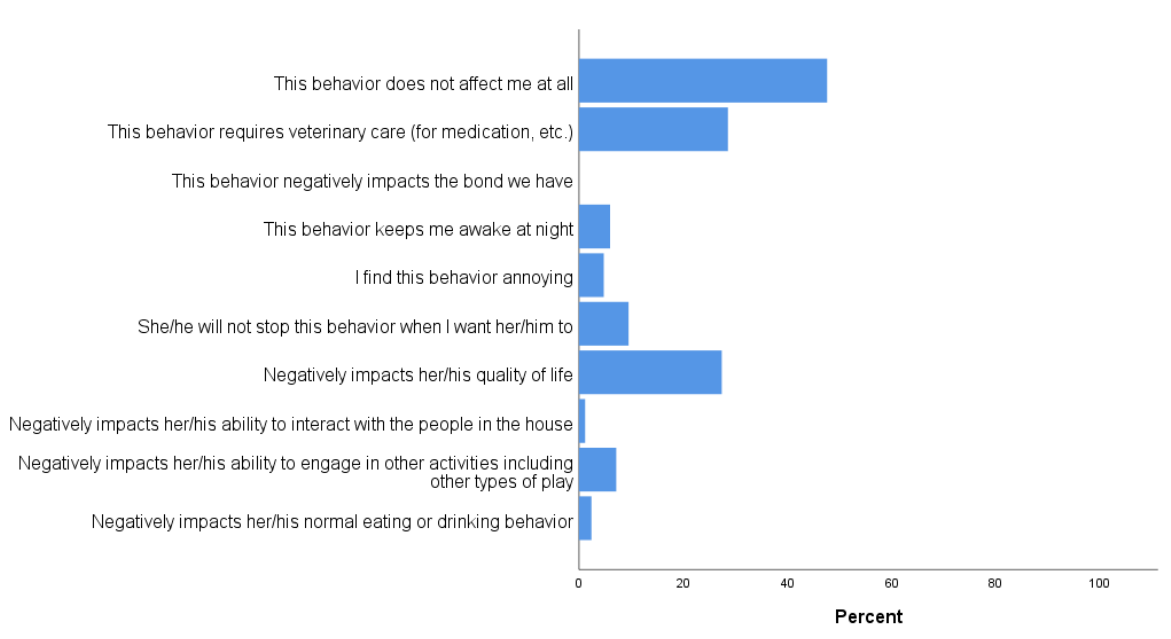
Figure 3. Cat guardian responses to questions related to the impact of overgrooming behaviors ( n = 84).